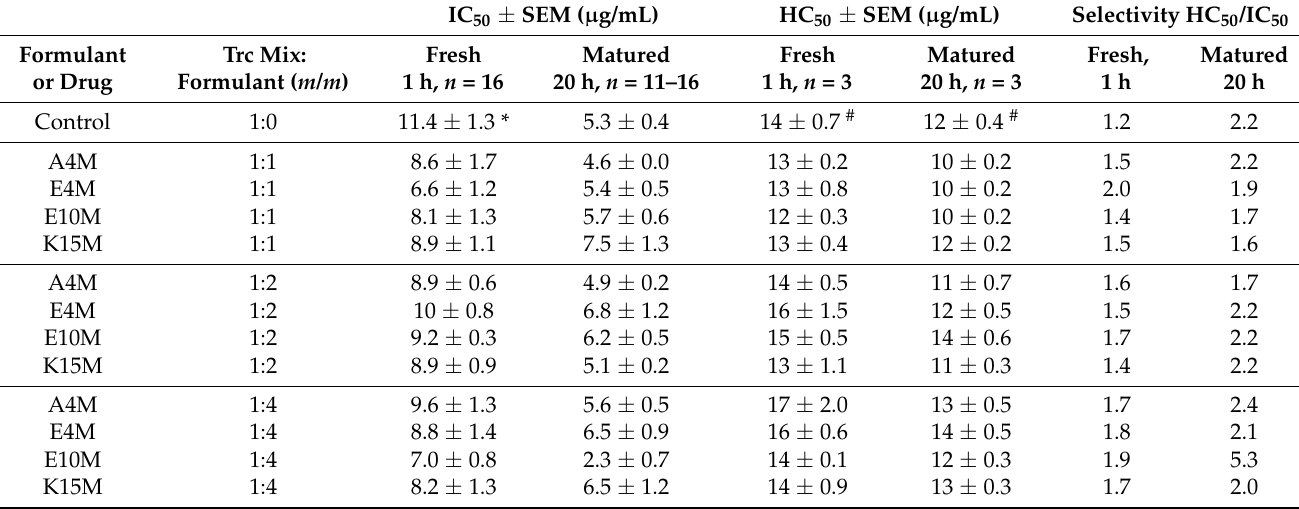
Figure 3. Metabolic inhibition of C. albicans cultures treated by formulated Trc mix at 50 µ g/mL ( A ), 25 µ g/mL ( B ) and 12.5 µ g/mL ( C ). Each data point represents one treated culture. The mean % metabolic inhibition, calculated in terms of growth controls, is shown for each condition with standard deviation (SD). Table 3. Summary of the IC 50 values of different preparations of the Trc mix against C. albicans . Refer to Tables S6 and S7 for statistical